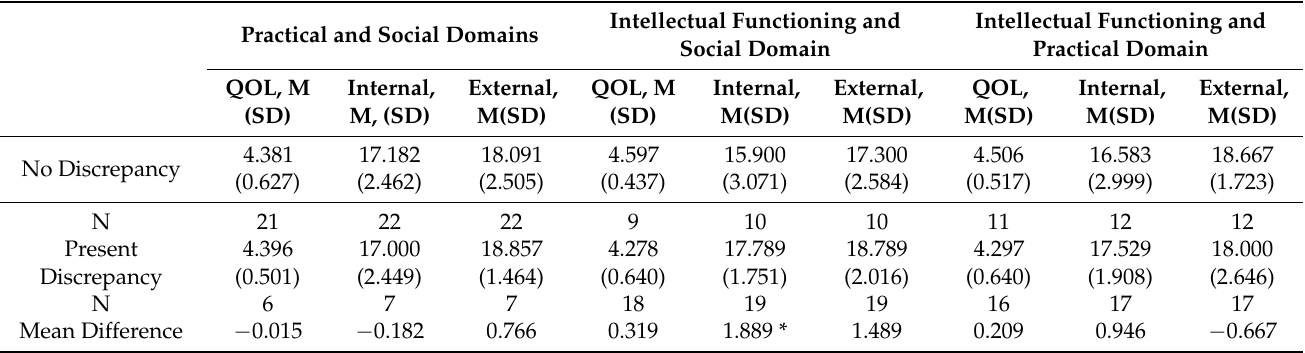
Table 4. Mean differences in self-reported QOL and internal and external maladaptive behavior with and without intellectual disability domain discrepancies (independent samples t